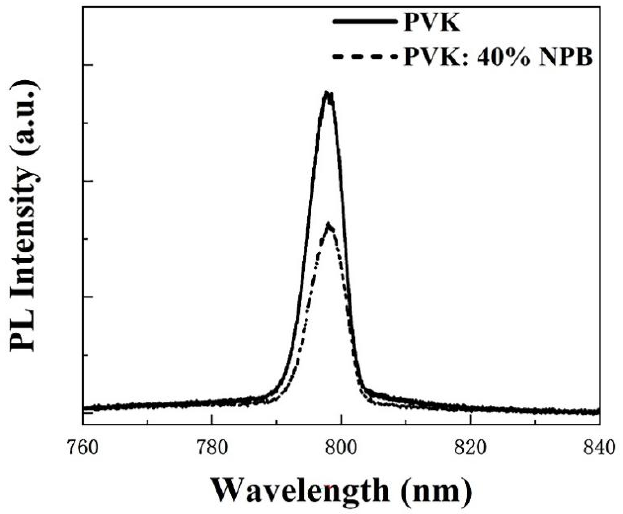
Figure 3. ( a ) UPS of PVK and PVK:40% NPB films and ( b ) the corresponding energy band alignment.